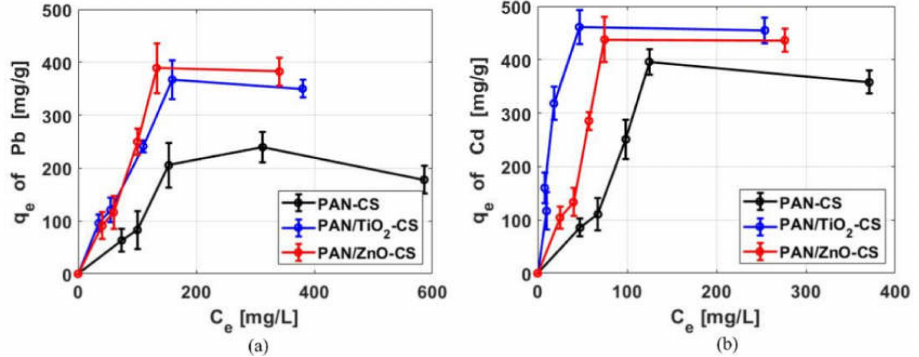
Figure 9. Adsorption isotherms of ( a ) lead and ( b ) cadmium ions by the bilayer PAN–CS and PAN / MO–CS nanofiber mats at room